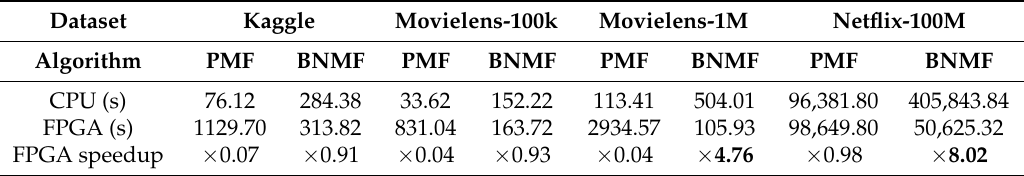
Table 3. Computing time (s) and FPGA speedup of PMF and BNMF algorithms for the CPU and FPGA